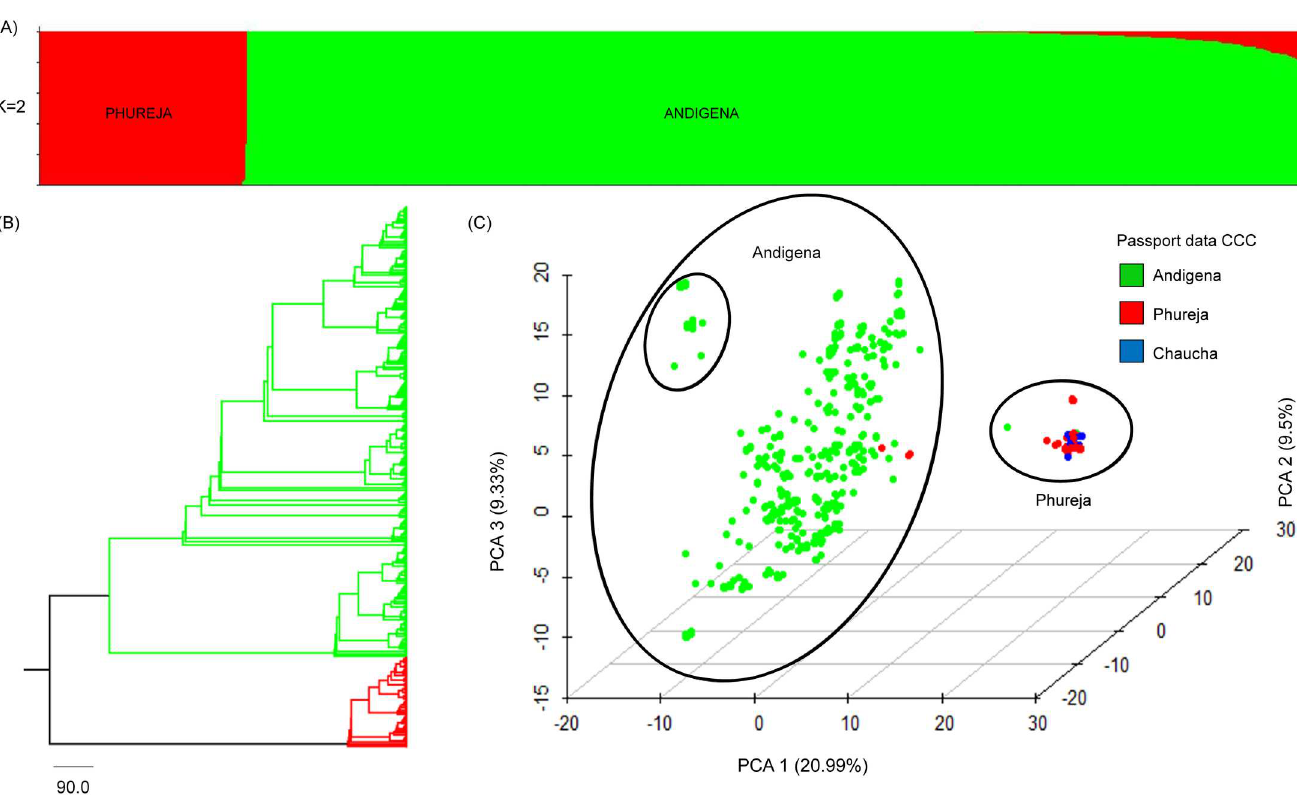
Fig 2. Population structure of 809 accessions of S . tuberosum group Andigenum. (A) ClusteringStructure analysis. (B) NJ-tree basedon Nei´s geneticdistances. (C) PrincipalComponent